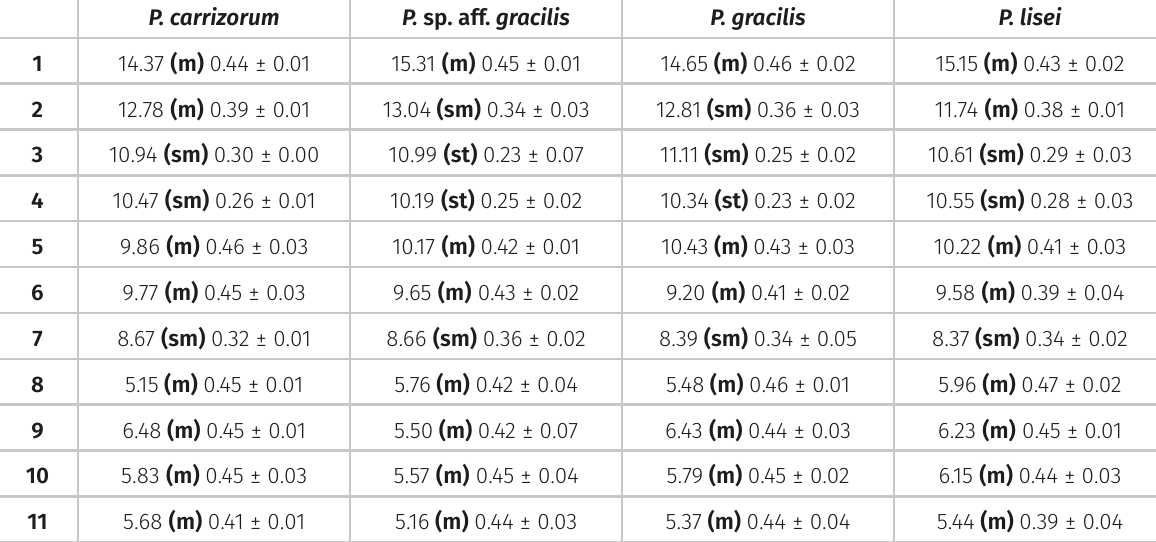
Table I. Chromosome measurements of species of the Physalaemus gracilis group. The chromosome percentage is relative to the haploid set. Centromeric index ± Standard Deviation. Chromosome morphology: metacentric (m); submetacentric (sm); subtelocentric